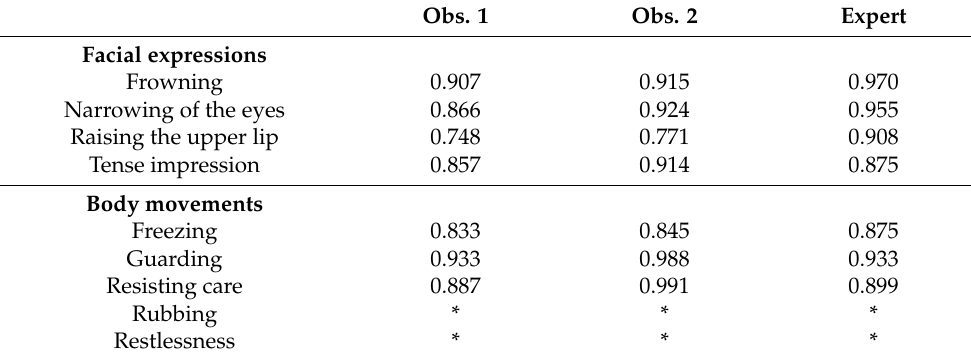
Table 1. Intraclass correlation coefficient (ICC) scores for the intra-observer reliability measure- ments of two inexperienced observers and one experienced observer in scoring pain-related facial expressions and body movements. Obs. 1 Obs. 2 Expert Facial expressions